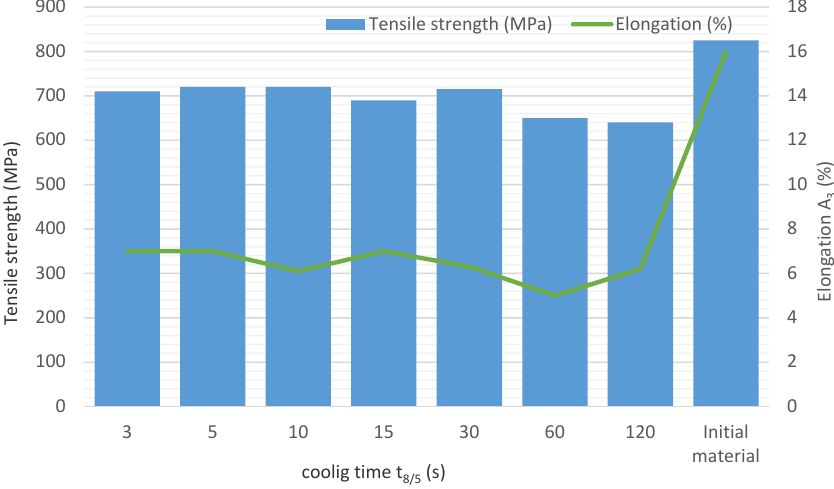
Figure 22. Tensile test and relative elongation of steel S700MC thermo-mechanically simulated HAZ area in of cooling time t 8/5 , the maximum temperature of thermal cycle was approximately 1250 °C.